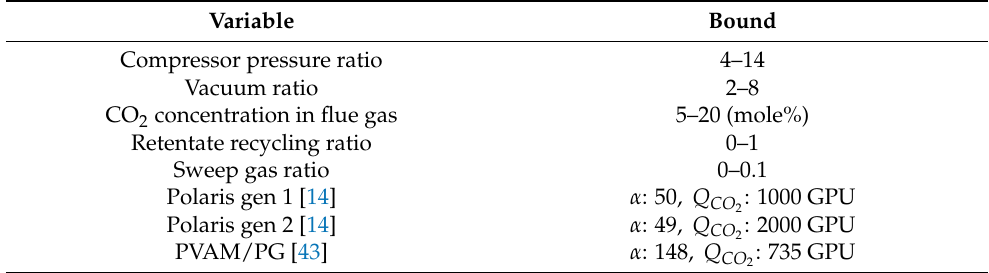
Table 4. The range of decision